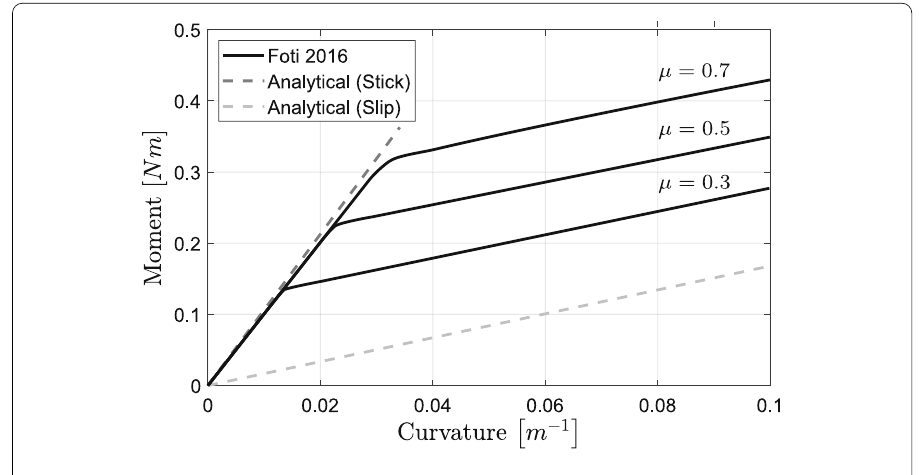
Fig. 6 Results by Foti [18] and stiffness values computed